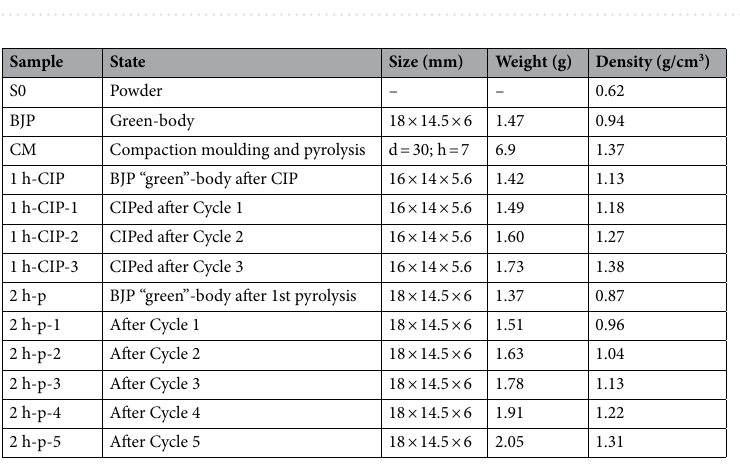
Figure 5. Dependence of the hybrid and compacted samples density on the number of pyrolysis cycles. 2nd to 6th pyrolysis was applied after PRBI. For compacted sample as initial density is the density before pyrolysis.